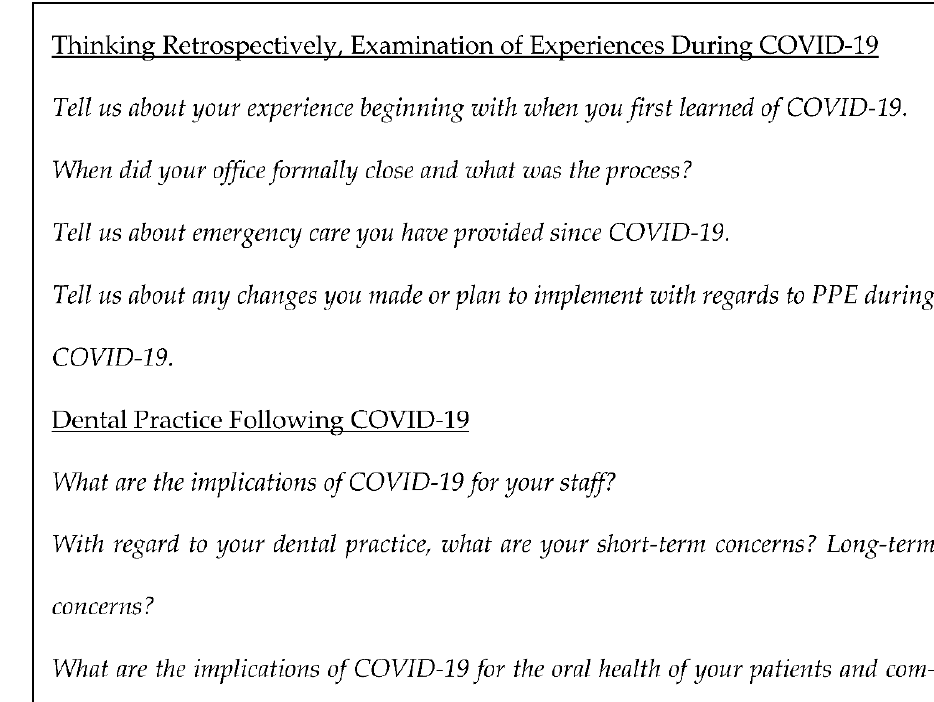
Figure 1. Interview Study Guide.